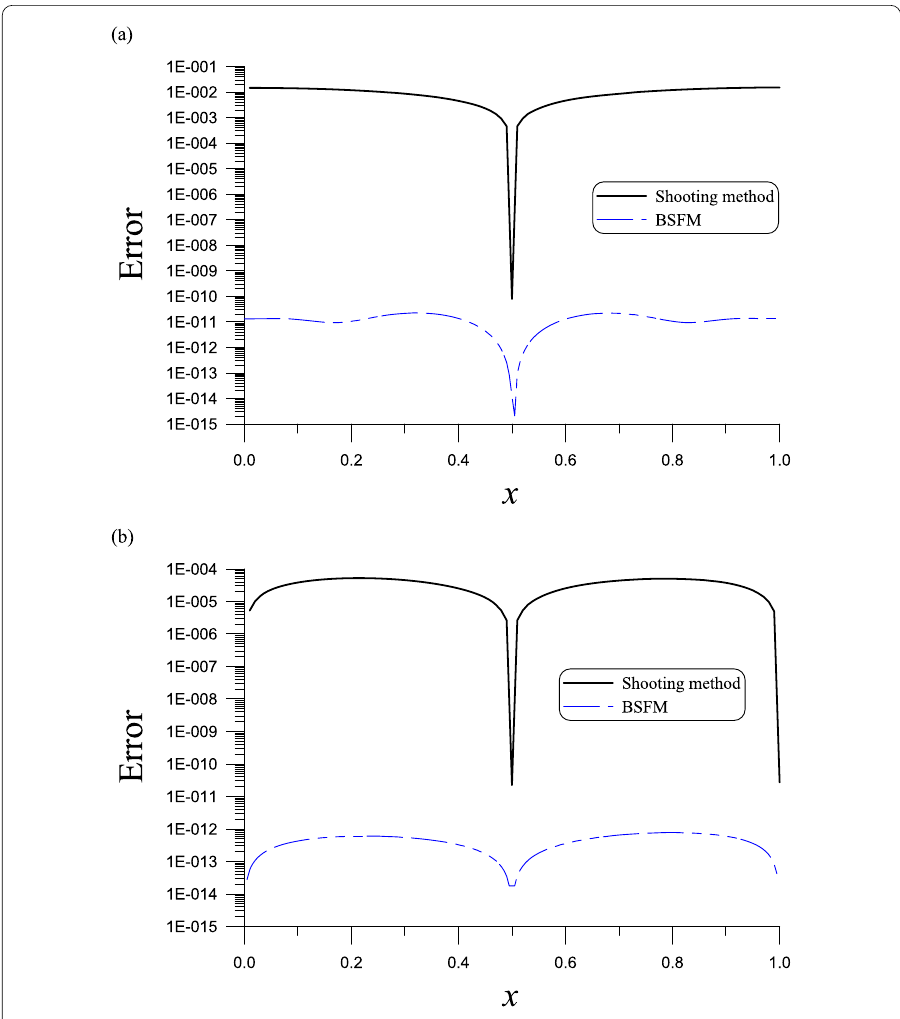
Figure 2 Comparing the numerical errors obtained by the shooting method and the BSFM for ( a ) Example 1 and ( b ) Example